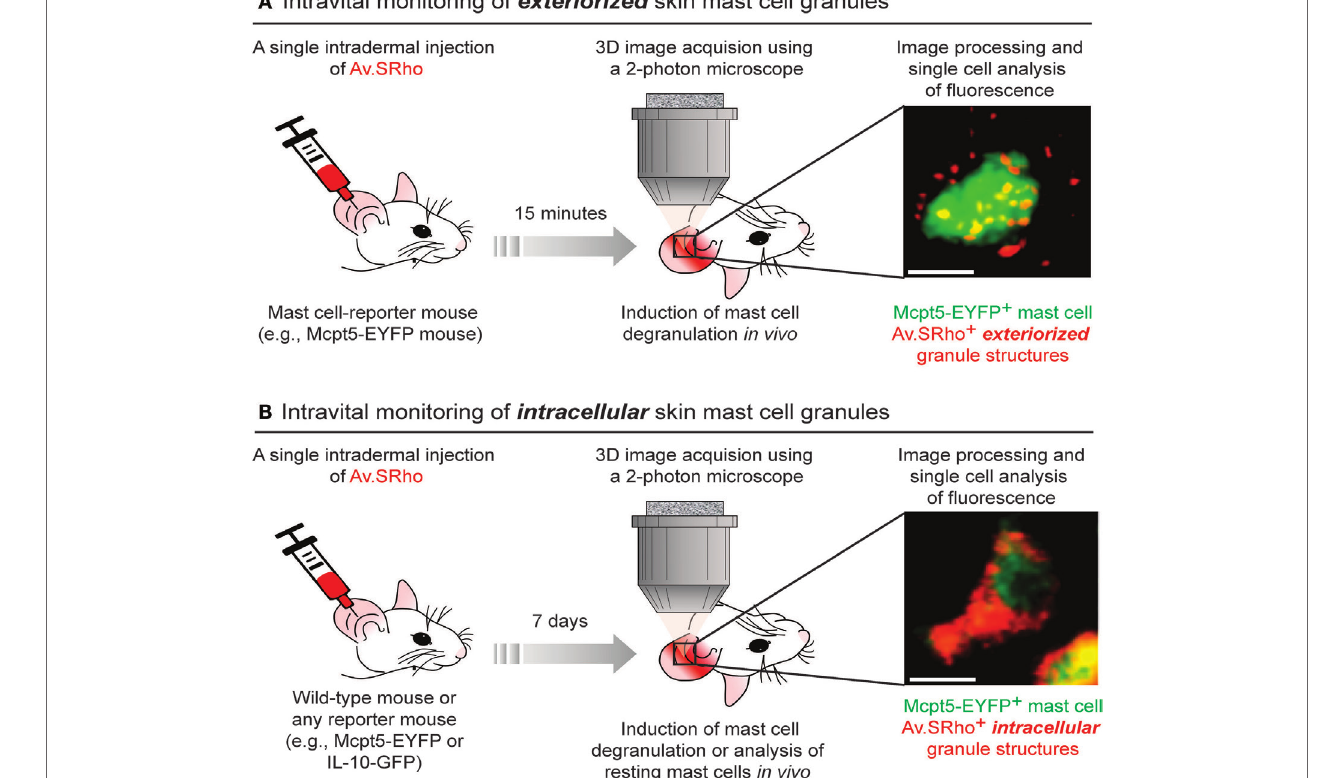
FiGURe 1 | Fluorochrome-labeled avidin can be used to probe either exteriorized or intracellular mast cell (MC) granule structures in living mice. (A) 5 µg of sulforhodamine 101-coupled avidin (Av.SRho) is injected intradermally (i.d.) into the ear pinna of a MC-reporter mouse (e.g., Mcpt5-EYFP). 15 min later, the mouse is anesthetized and placed under a two-photon microscope; MC degranulation is induced by i.d. injection of stimulus; 3D high-resolution images of single cells are taken and Av.SRho fluorescence signal is assessed. The photograph shows a single dermal EYFP + MC activated upon i.d. injection of substance P exhibiting Av.SRho + exteriorized small granule structures. Image extracted from Gaudenzio et al. (38). (B) 5 µg of Av.SRho is injected i.d. into the ear pinna of a mouse. 7 days later, the mouse is anesthetized and placed under a two-photon microscope; 3D high-resolution single-cell images are taken and Av.SRho fluorescence signal is assessed. The photograph shows a single EYFP + MC exhibiting Av.SRho + intracellular granule structures. Image extracted from Reber et al.